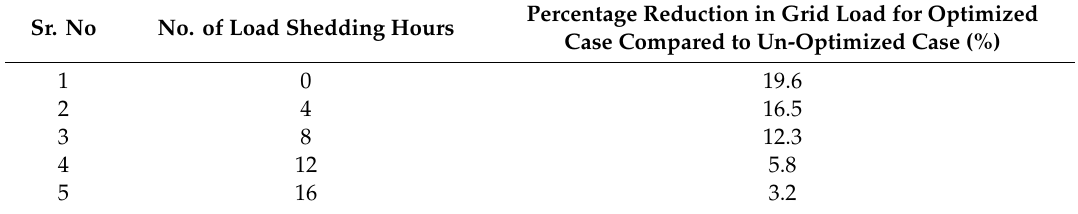
Table 1. Percentage reduction in grid load in various intermittence